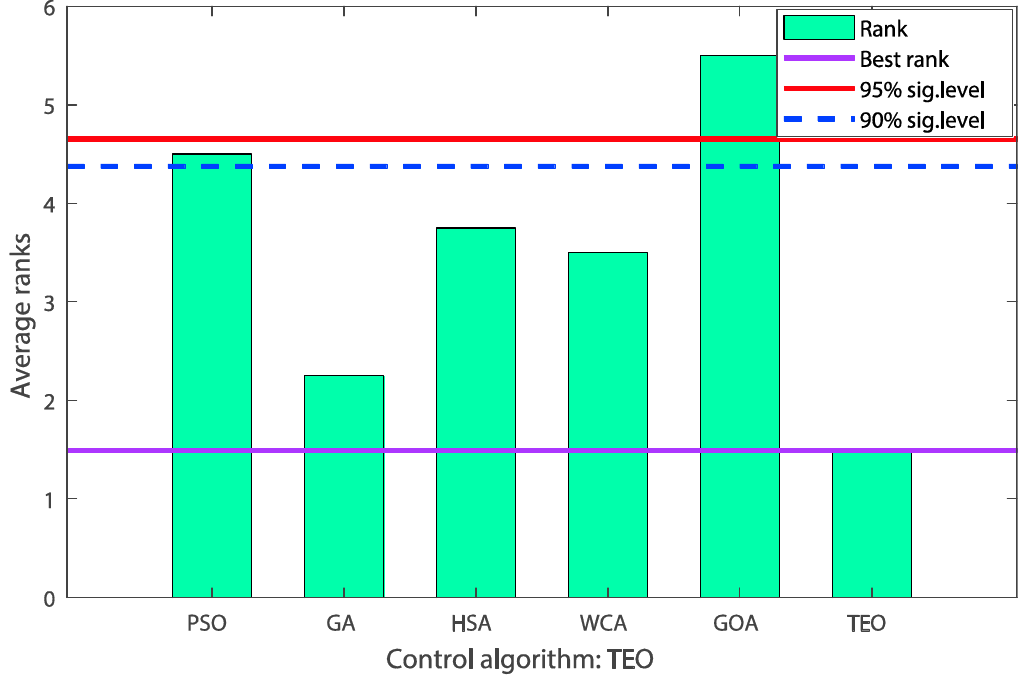
Figure 16. Graphical representation of Bonferroni–Dunn’s test for problem (19).